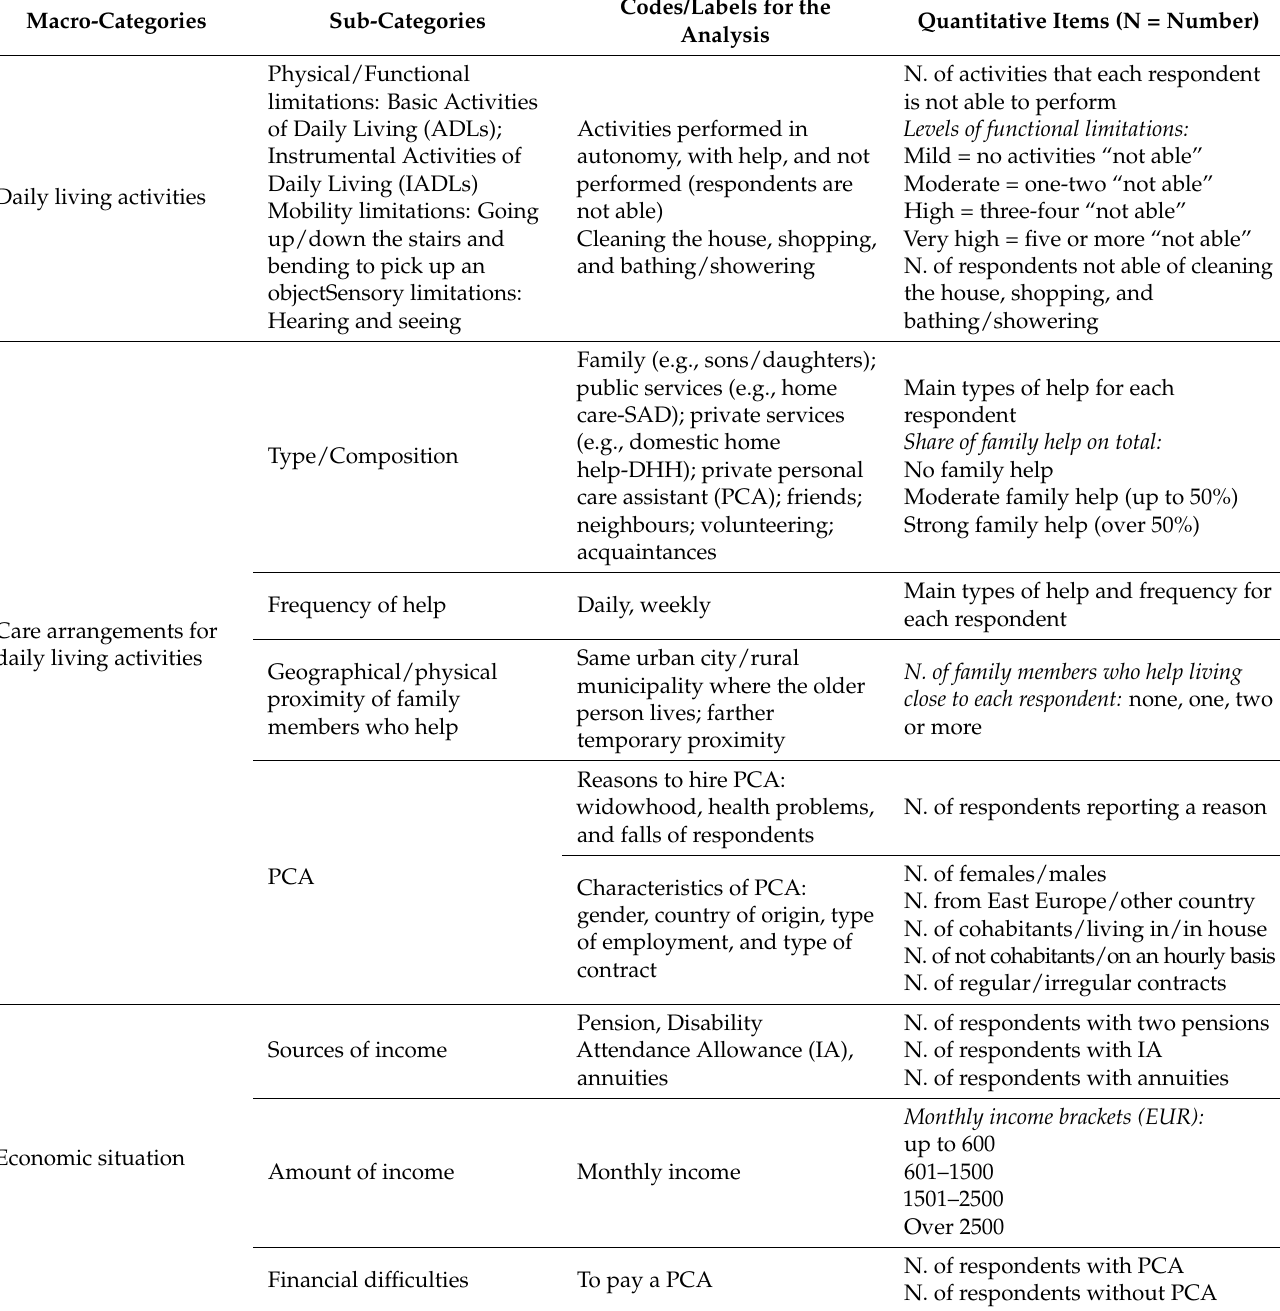
Table 2. The process of categorization, coding, and